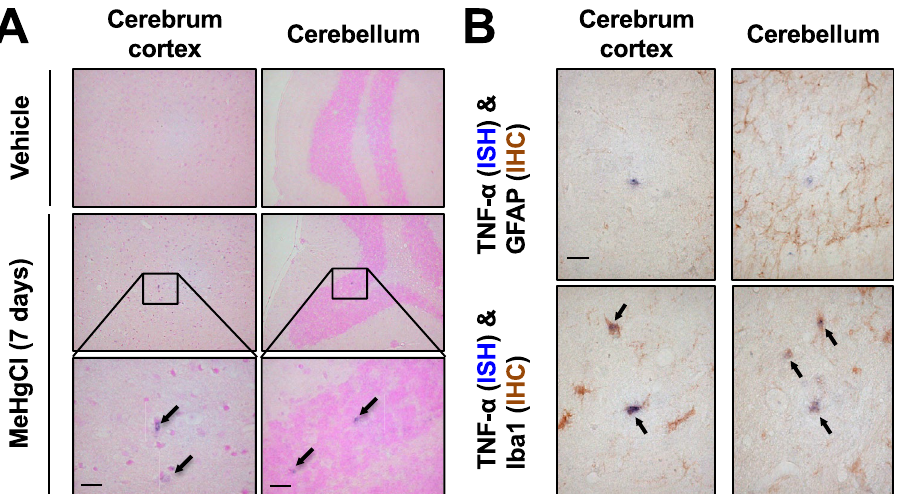
Figure 1. TNF-α expressing cells in the brains of mice treated with methylmercury. ( A ) Mice were injected with methylmercuric chloride (MeHgCl; 25 mg/kg) by S.C. and kept for 7 days ad libitum . The brains were subjected to in situ hybridization for TNF-α mRNA. Representative images are shown. Black arrows indicate TNF-α expressing cells. ( B ) The section was immunostained for GFAP or Iba1 antibodies. Black arrows indicate double positive cells of TNF-α and Iba1. Scale bars indicate 25